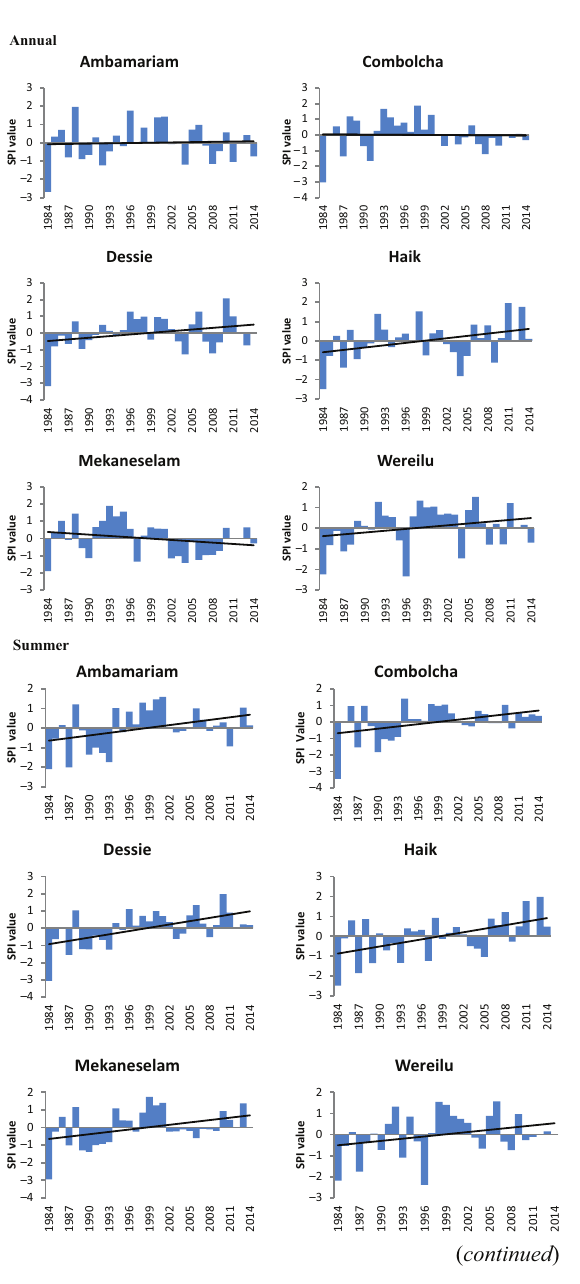
Figure 3. Magnitude and frequency of SPI values at annual, summer and spring time